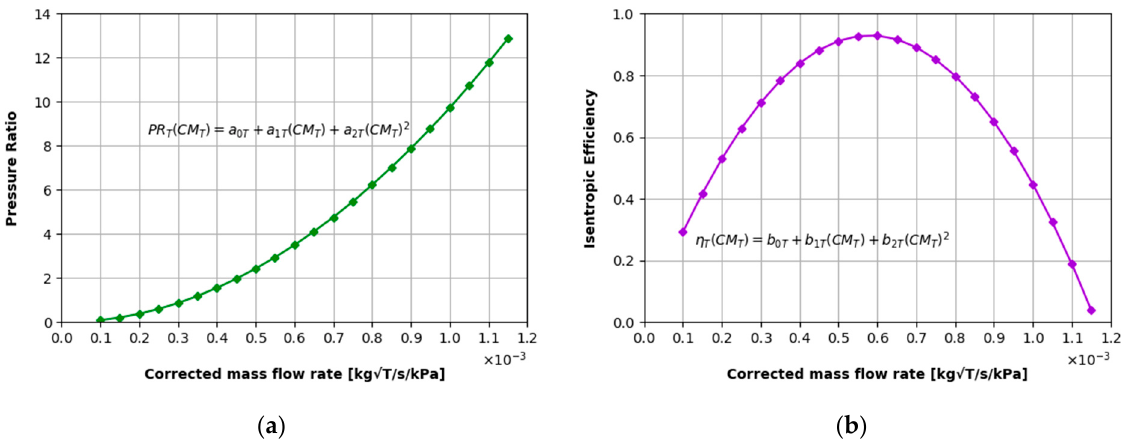
Figure 7. ( a ) Pressure ratio vs. corrected mass flow rate for the turbine; ( b ) Isentropic efficiency vs. corrected mass flow rate for the turbine. Table 3. Coefficients for the second-order polynomial machine performance curves.